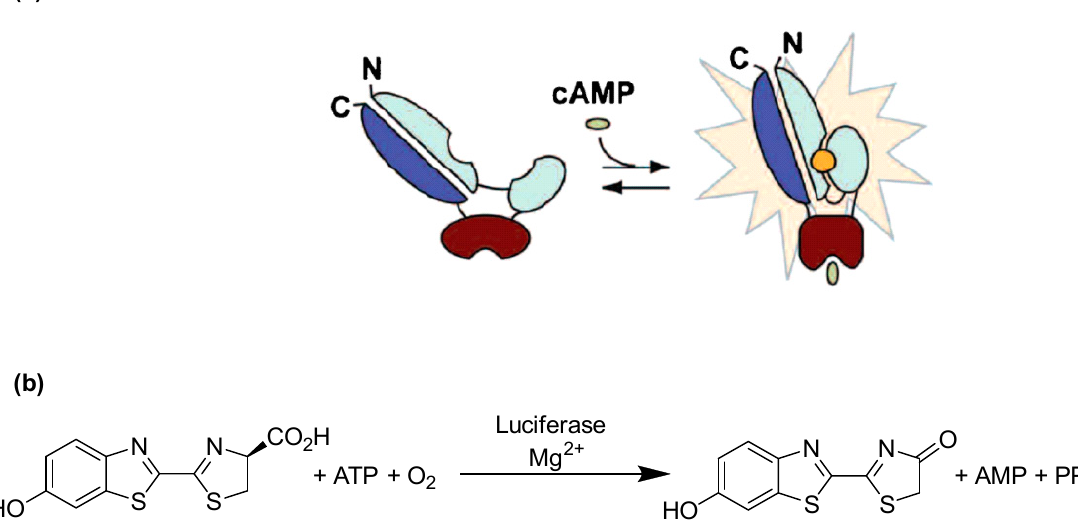
Figure 1. Principle of cAMP detection using the engineered GloSensor luciferase. ( a ) GloSensor luciferase in the open conformation shows negligible activity resulting in a low luminescence background, whereas binding of cAMP to the cAMP binding site favors the closed conformation and hence activates the luciferase, which metabolizes luciferin to oxyluciferin, producing luminescence. ( b ) Luciferase catalyzes the oxidation of luciferin using molecular oxygen and ATP in the presence of Mg 2+ to produce oxyluciferin, which is highly unstable in an electronically excited state and produces light upon returning to its electronical ground state. Modified based on published figure [25].